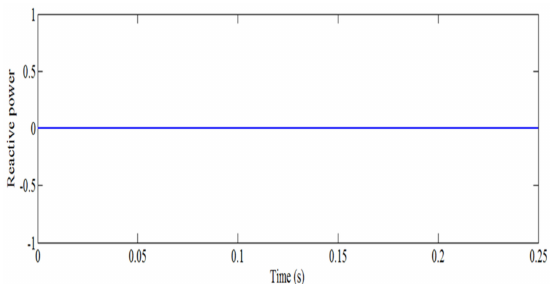
Figure 15. Real power from generation.